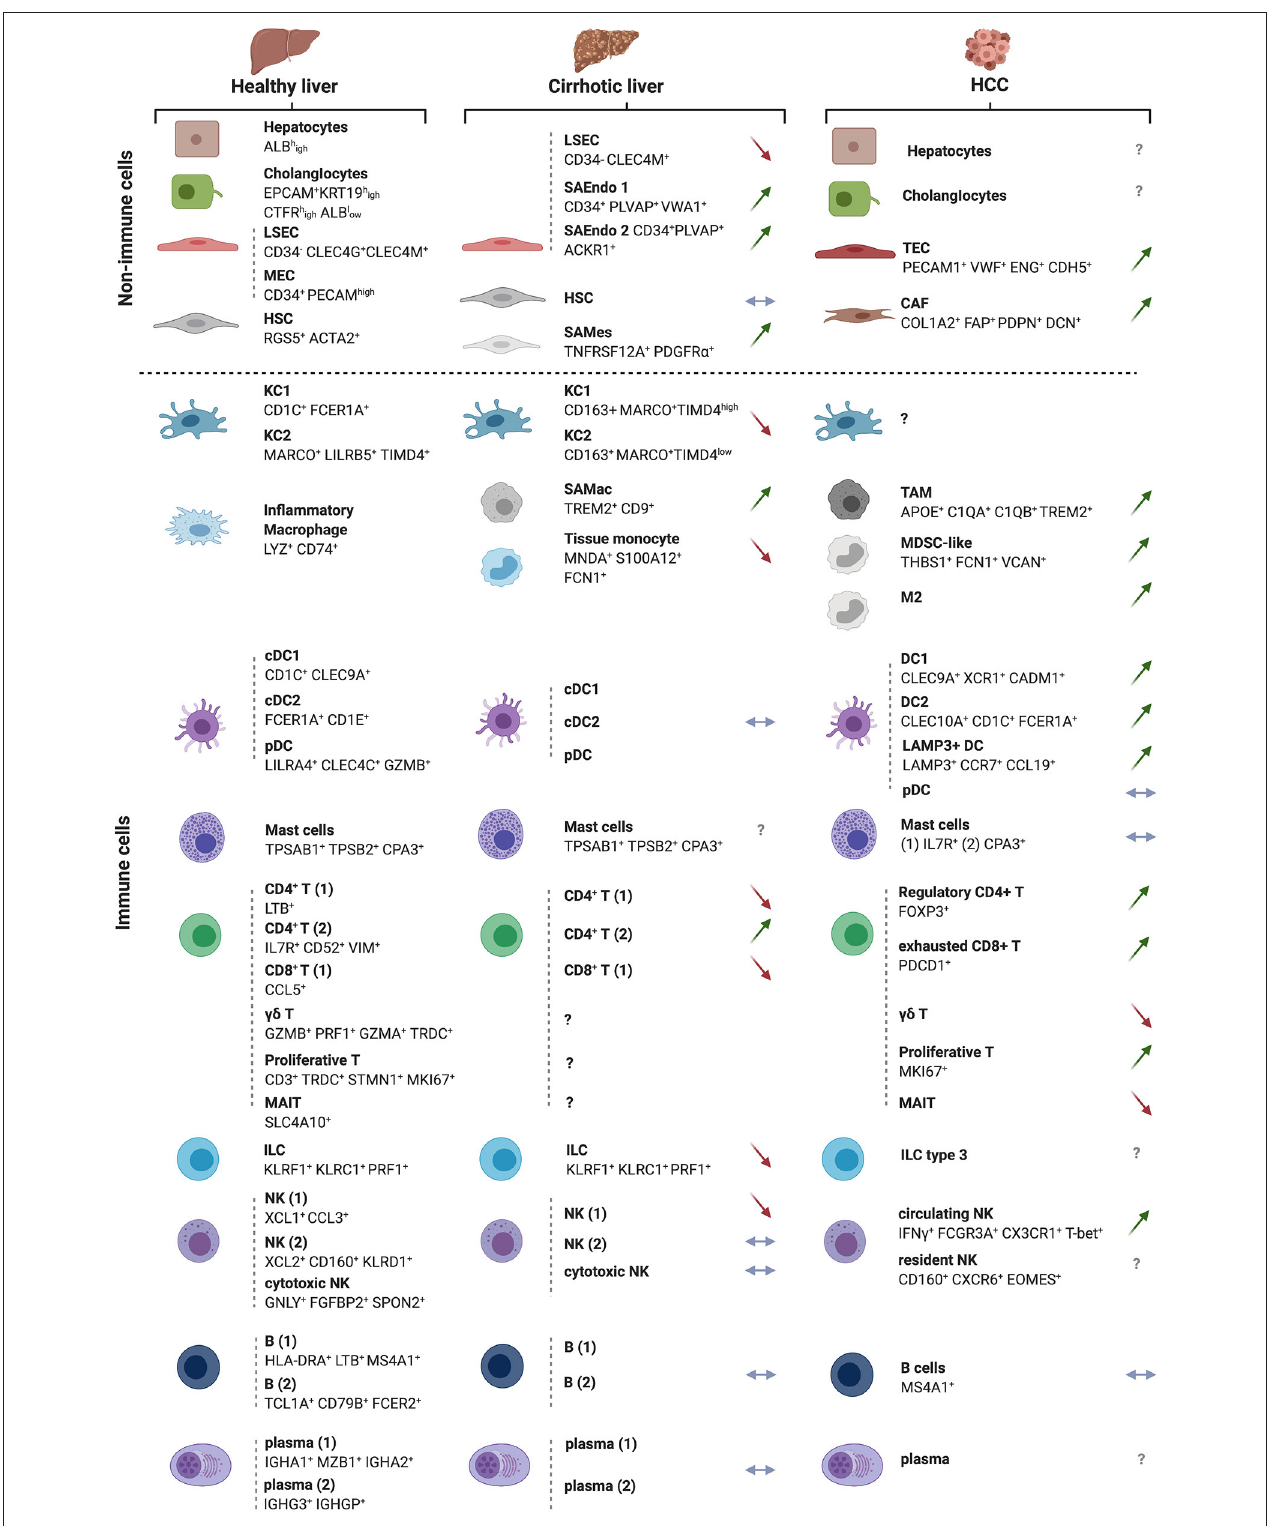
FIGURE 3 | The landscapes of the normal, cirrhotic and HCC-bearing livers. All immune and non-immune cell types identified by high-resolution single cell analyses of the human healthy and cirrhotic livers and of HCC are illustrated along with their discriminatory markers. Arrows depict direction of change in cirrhosis or HCC